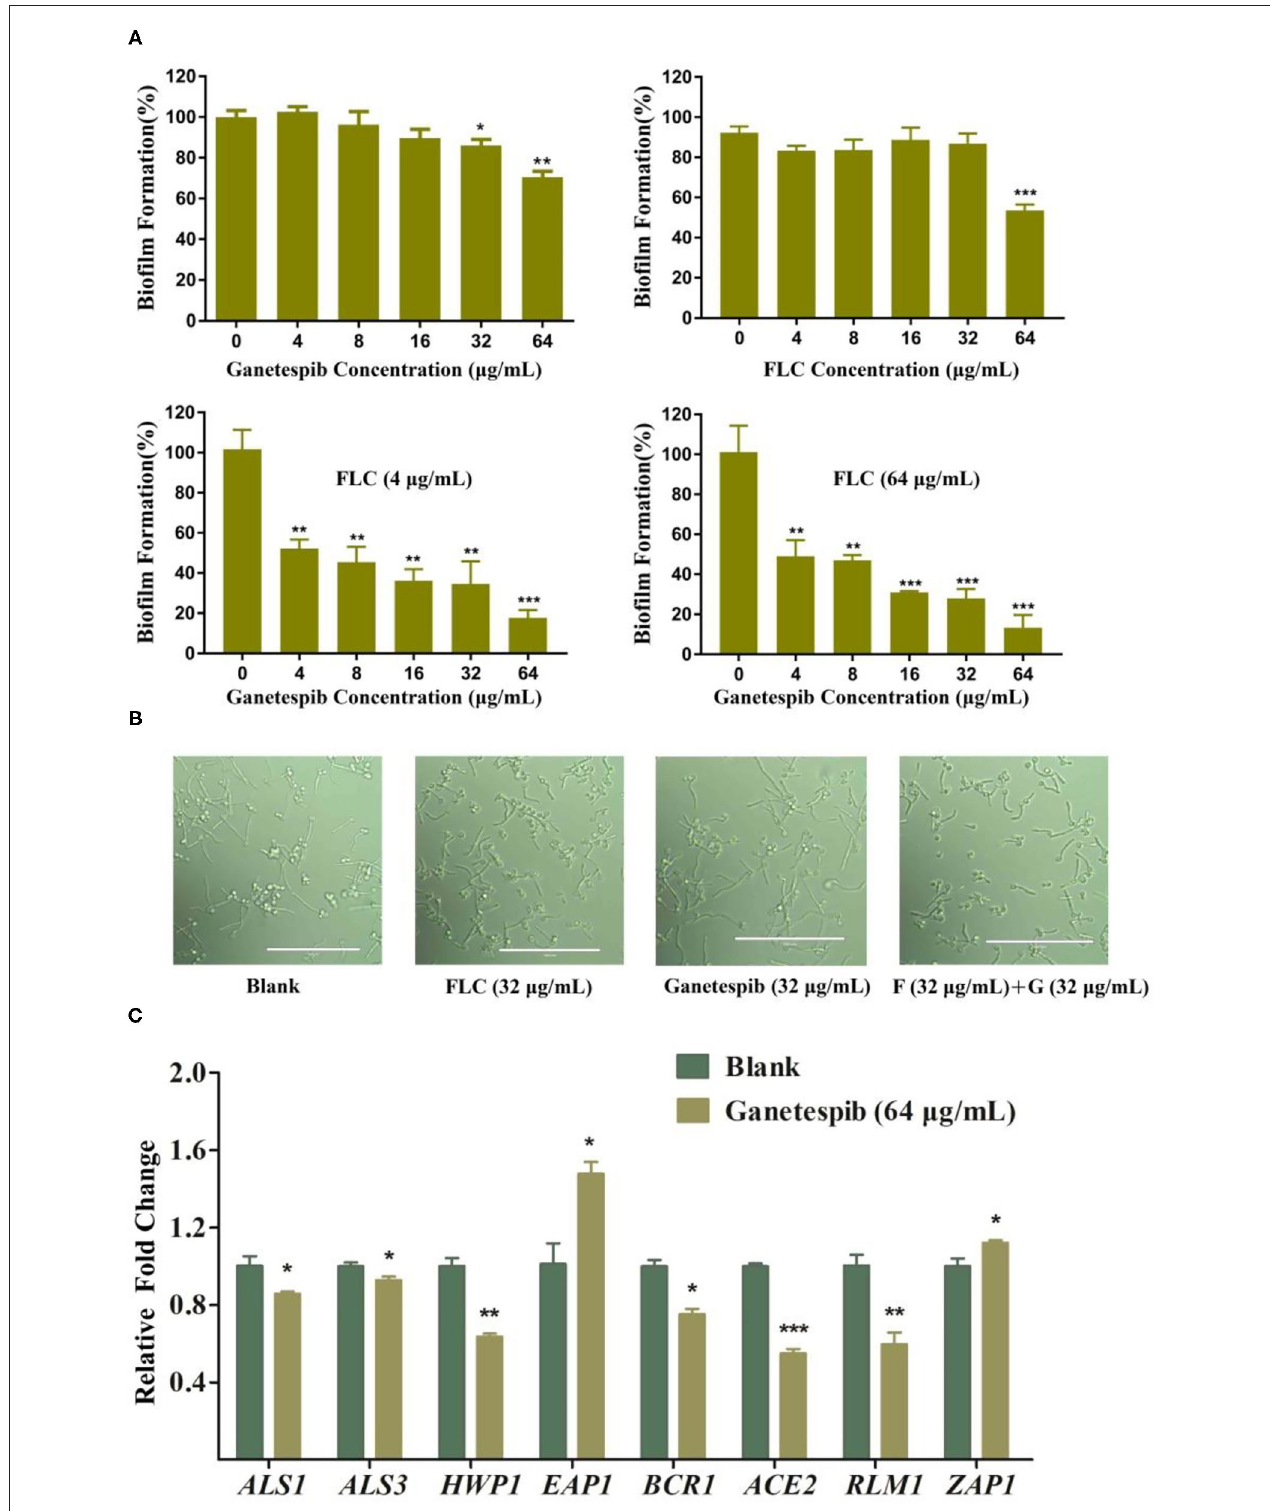
FIGURE 3 | (A) Effect of ganetespib, FLC, or both on the C. albicans 0304103 biofilm formation. (B) Filamentation microscopic observation of C. albicans 0304103 treated with FLC (F), ganetespib (G), or their combination. (C) Expression levels of biofilm formation-related and filamentation genes (* P < 0.05, ** P < 0.01, *** P < 0.001, determined by Student’s t